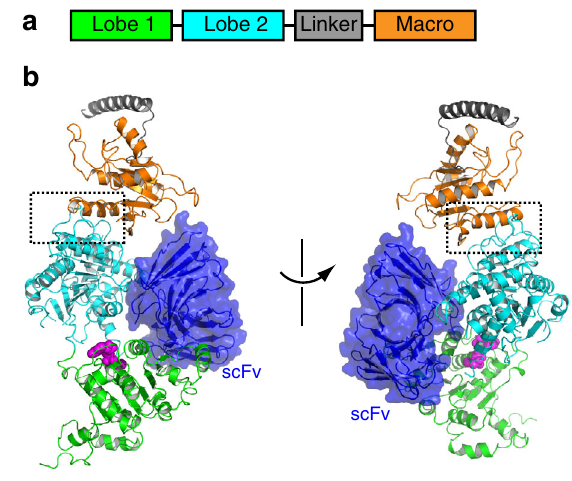
Fig. 1 Structure of ALC1 in the autoinhibited state. a Domain architecture of ALC1. b Two different views of the crystal structure of ALC1 in the autoinhibited state. Bound nucleotide are colored magenta spheres. The boxed region is enlarged for analysis in Fig. 2. The bound scFv is colored